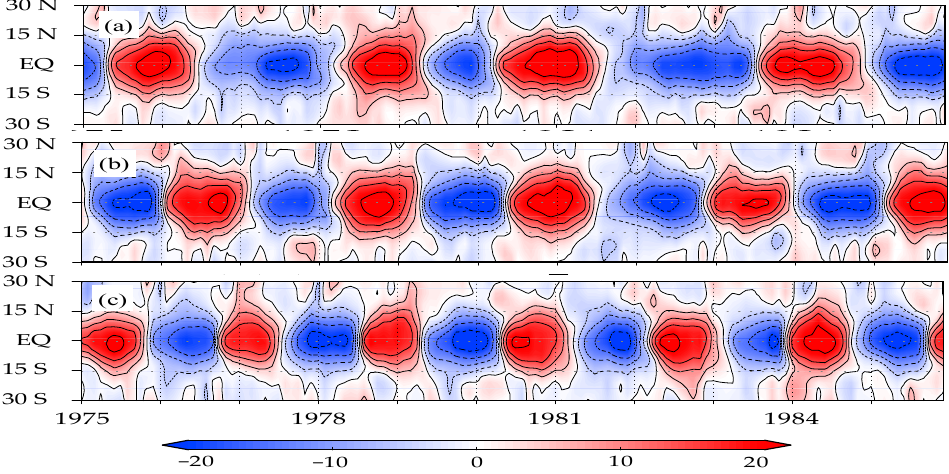
Figure 8. Time–latitude cross-sections of zonal–mean zonal wind anomalies at 20 hPa for the ( a ) P, ( b ) ST, and ( c ) N runs from 1975 to 1985. Units of the color bar scale are in ms − 1 , and the contours interval is 5 ms − 1 .